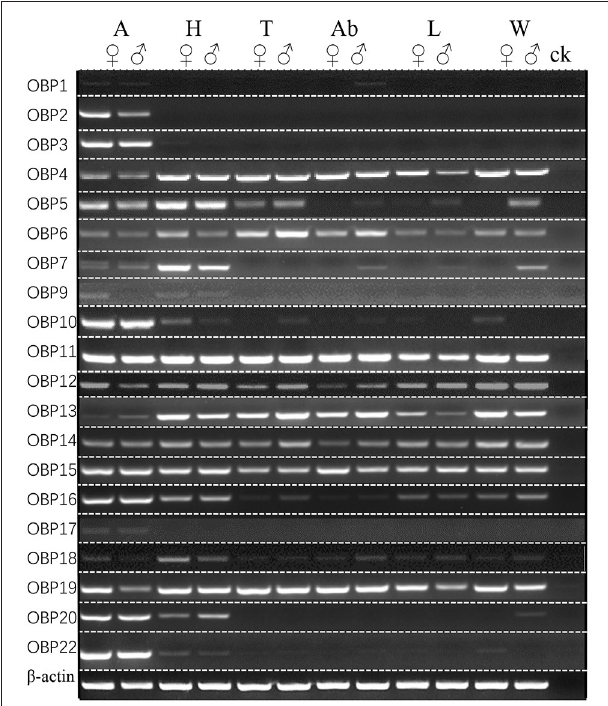
FIGURE 7 | Sex- and tissue-specific expression of candidate ScosOBPs. A, antennae; H, head; T, thorax; Ab, abdomen; L, leg; W, wing; ck, control [ultra-pure water (germ-free)].